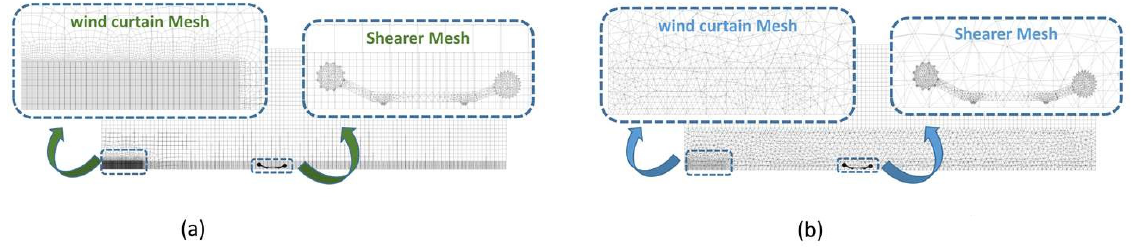
Figure 4. Meshing comparision of different methods. ( a ) Multizone meshing; ( b ) Automatic mesh- ing.